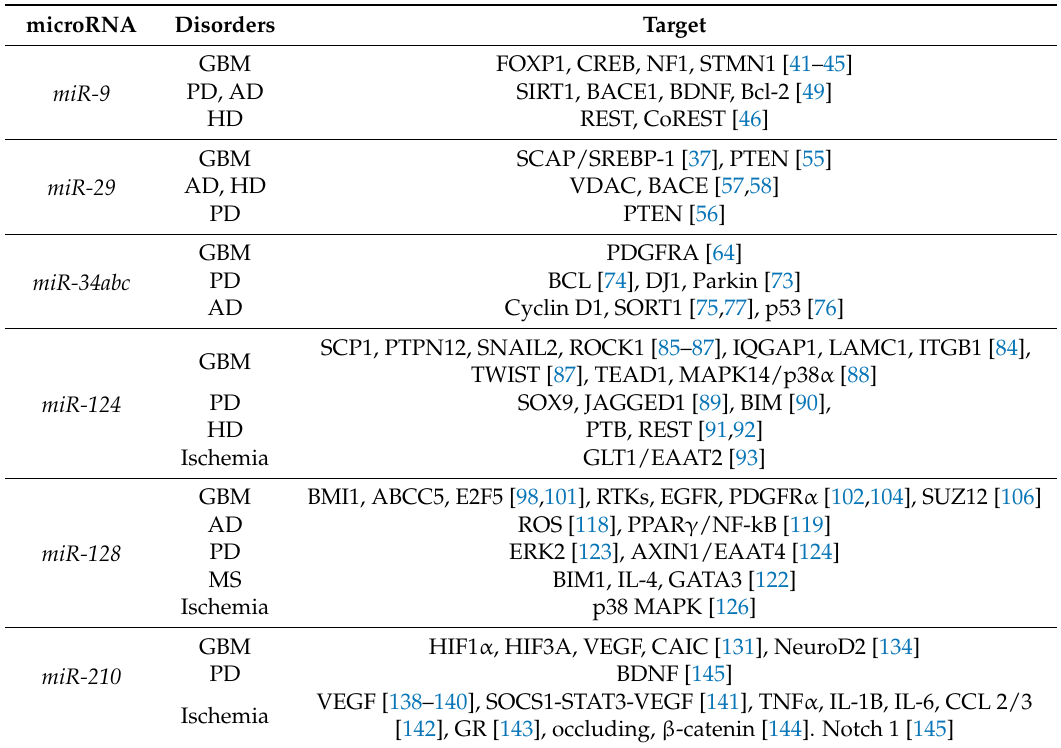
Table 1. Functional microRNAs deregulated in brain